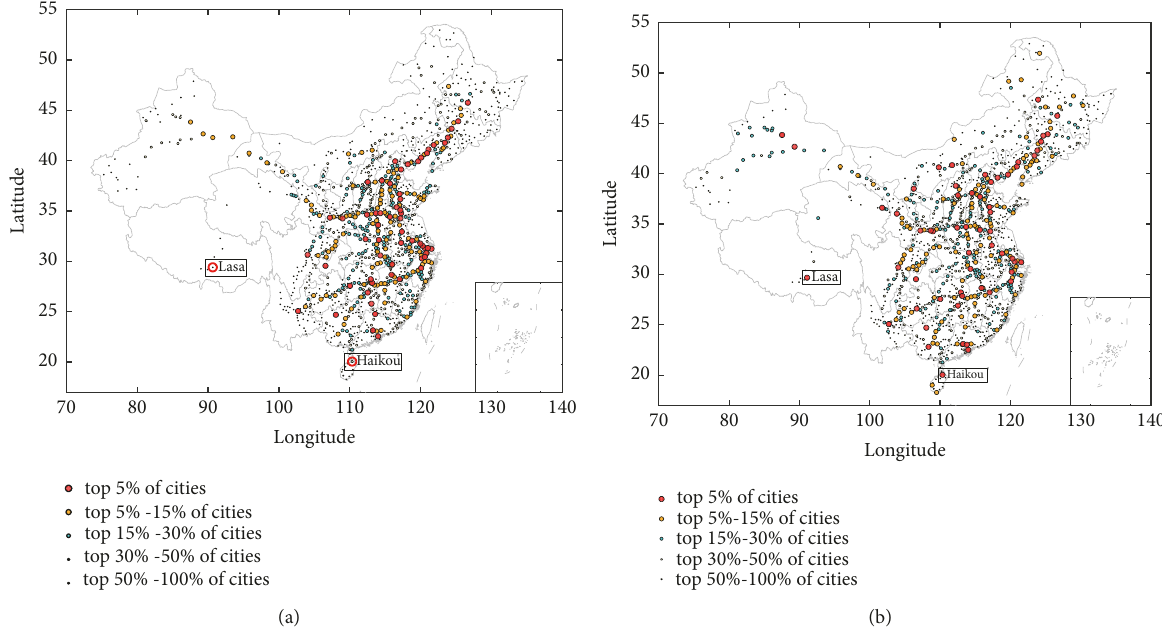
Figure 7: (a) The spatial distribution of cities classified by nodal degree value in descending order. (b) The spatial distribution of the cities classified by nodal betweenness value in descending order.